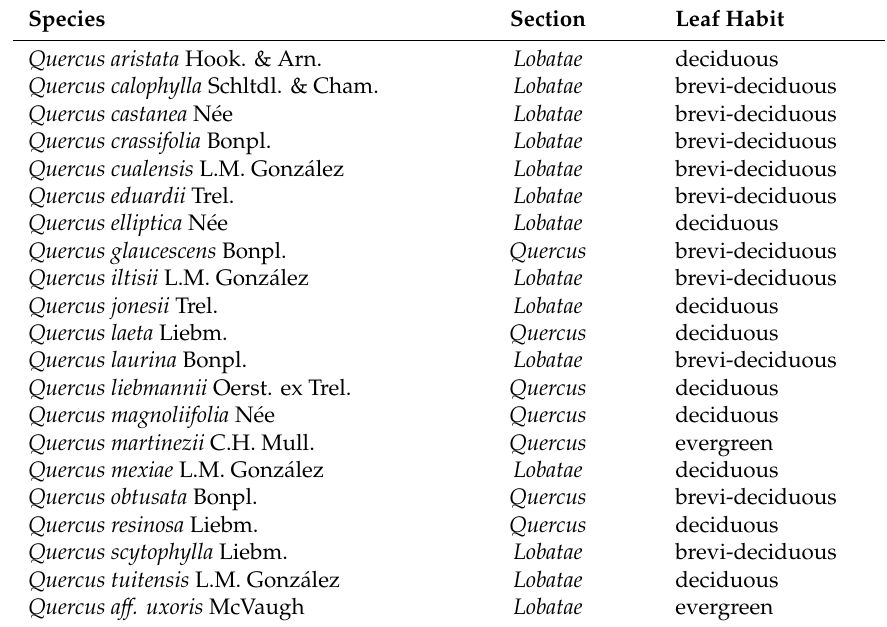
Table 1. List of oak species in the study with the phylogenetic section and leaf habit category. Species